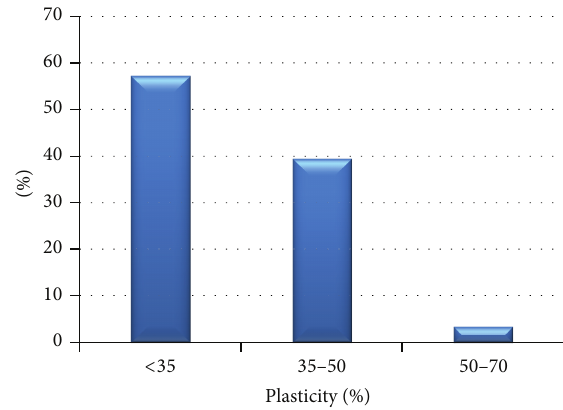
Figure 7: Plasticity according to liquid limit of studied sample (low plasticity 𝑤 𝑙 < 35 %, intermediate 𝑤 𝑙 = 35 – 90 %, and high 𝑤 𝑙 = 50 – 70